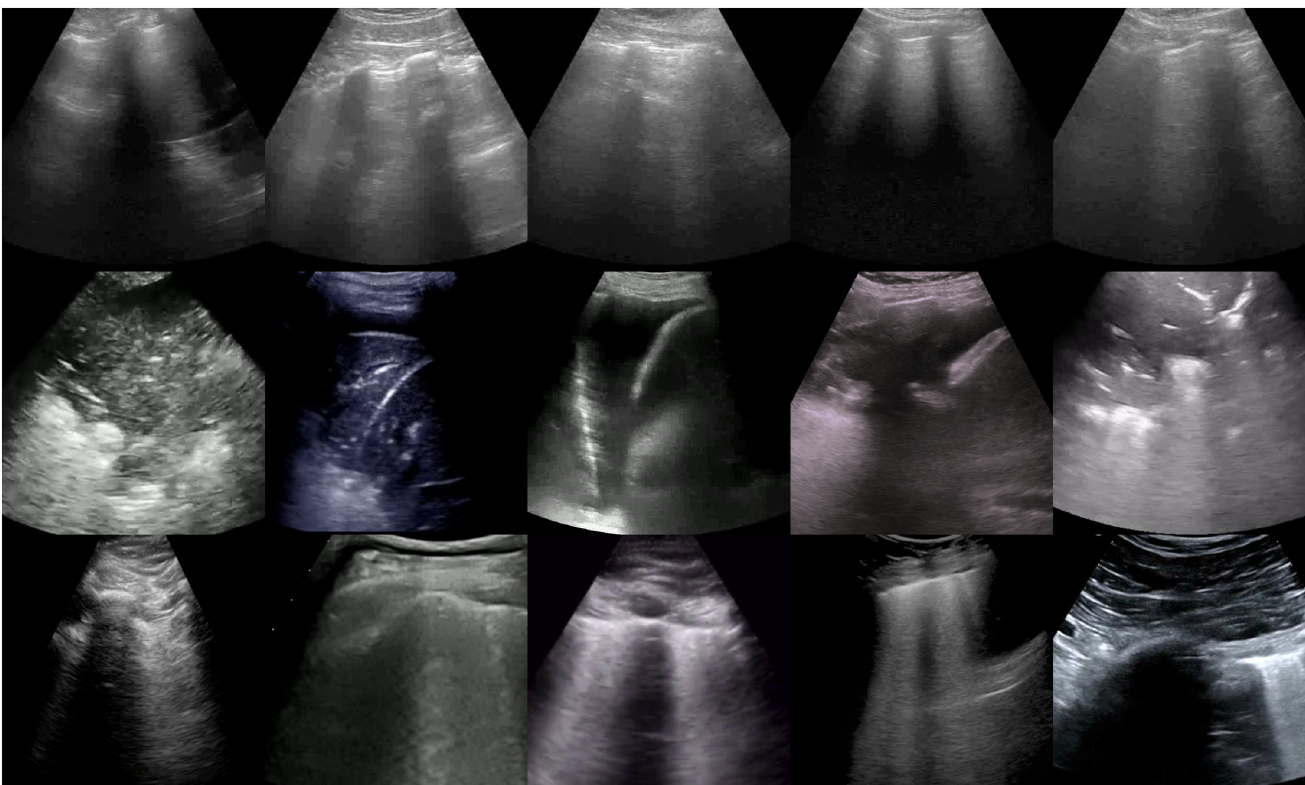
Fig 3. Examples of images obtained from LUS videos after pre-processing. Healthy (first row), pneumonia (second row), and COVID-19 (third row) LUS image classes.